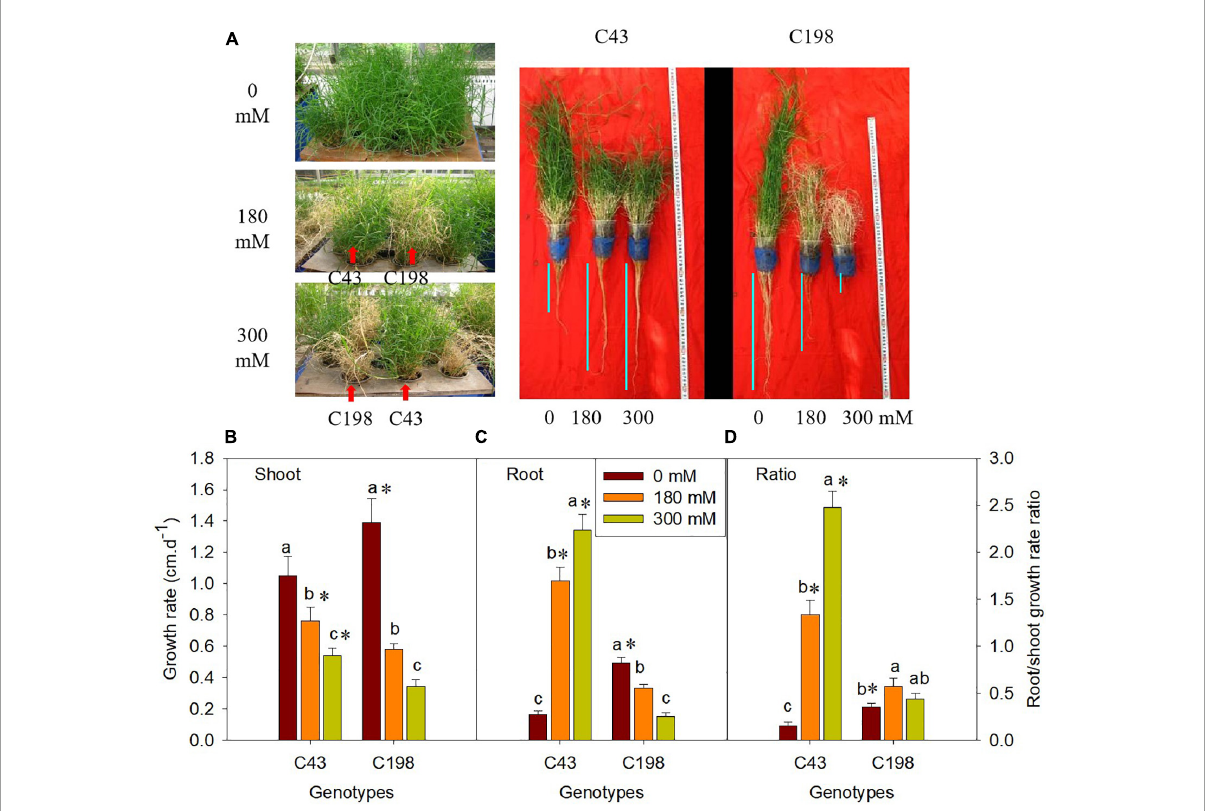
FIGURE1 Effect of salt stress on phenotype of bermudagrass ( A ; C43, tolerant genotype; C198, sensitive genotype), and on the shoot growth rate (B) , root growth rate (C) and root/shoot ratio (D) in two genotypes of bermudagrass. Bars marked by the same letters are not significant at P < 0.05 (Tukey’s test) for the comparison of different salt concentrations within a given genotype. Bars marked with star (*) indicate significance at P < 0.05 (Tukey’s test) between the two genotypes at a given salt concentration. Data represent the mean ± SD of four independent biological